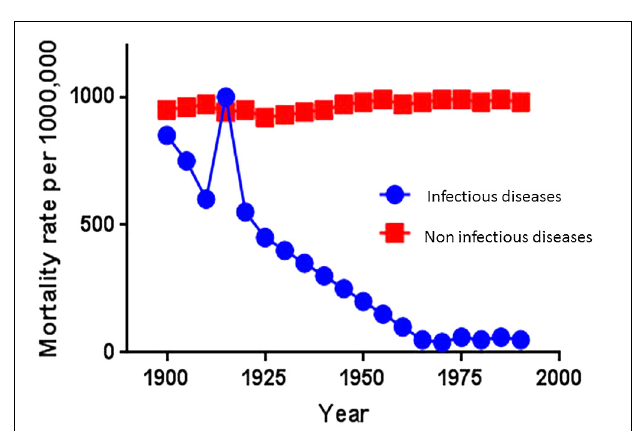
FIGURE 5 | Tendency of human mortality rates associated with infectious diseases and non-infectious diseases in the US during the 20th century (Armstrong et al.,